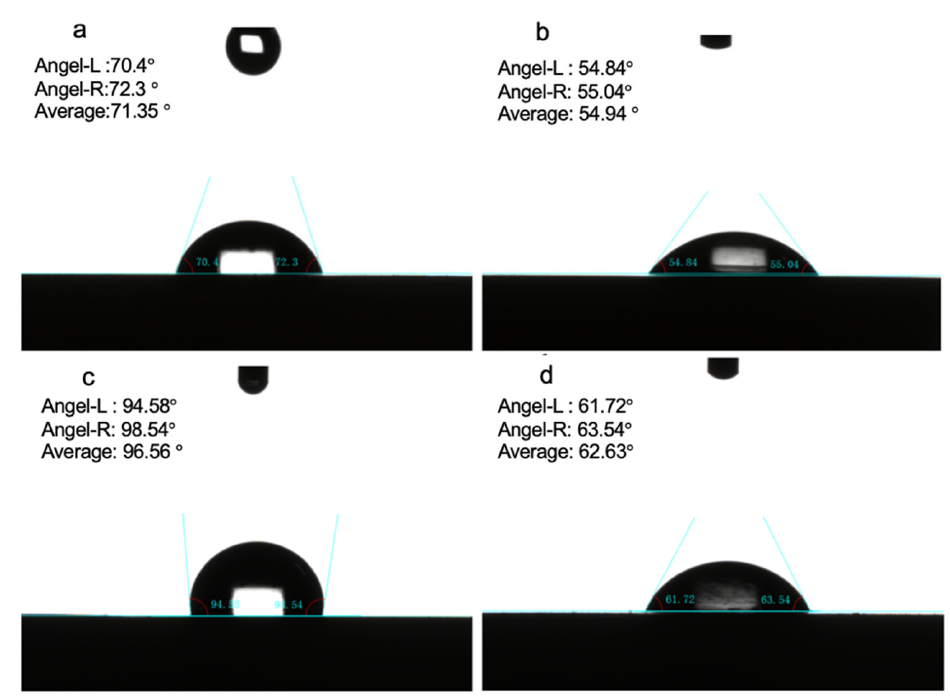
Figure 3. The contact angle image of ( a ) Ti, ( b ) Ti ‐ OH, ( c ) Ti ‐ DA, and ( d ) Ti ‐ gel.